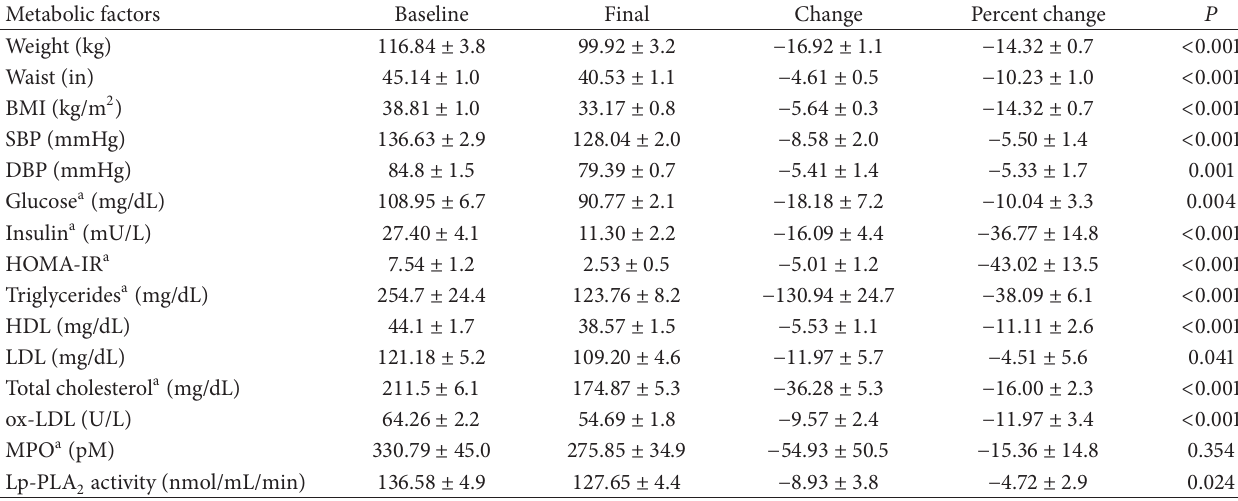
Table 3: Change in metabolic factors b following rapid weight loss among 40 obese adults with the metabolic syndrome (values are expressed as means ± SE).